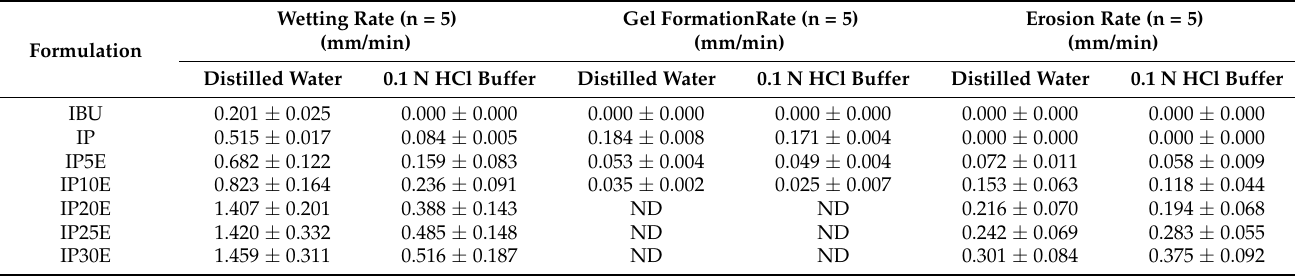
Figure 2. ( A ) Photomicrographs of eutectic effervescent tablets in distilled water under stereomicro- scope at magnification of 15×. ( B ) Photomicrographs of eutectic effervescent tablets in 0.1 N HCl buffer pH 1.2 under stereomicroscope at magnification of 15×. Table 2. Rate of wetting, gel formation, erosion and dissolution parameters of eutectic effervescent tablets in various testing